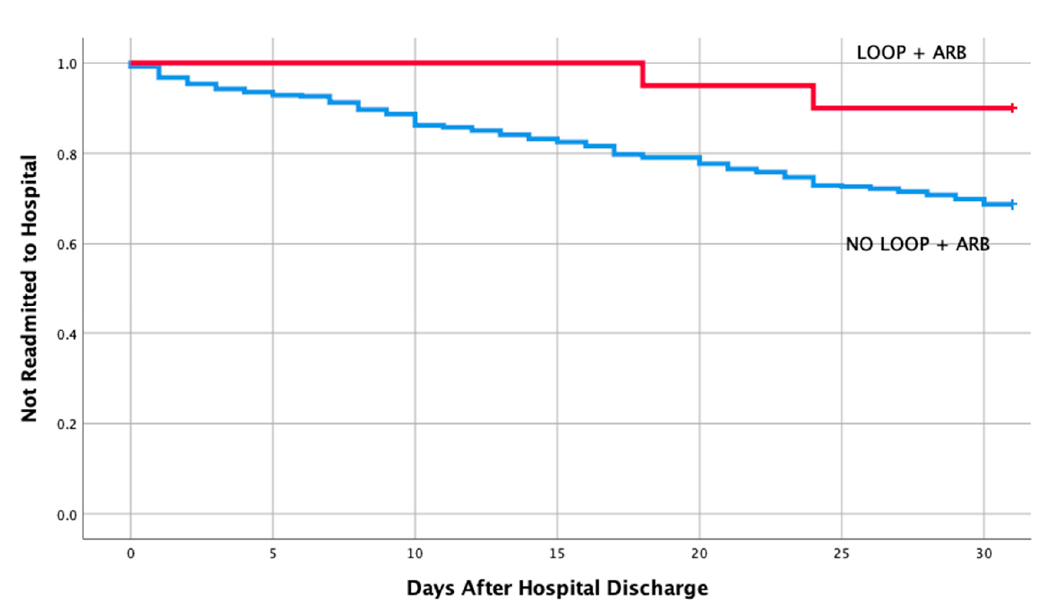
Figure 4. Readmission free survival for patients treated with loop + angiotensin receptor blocker.